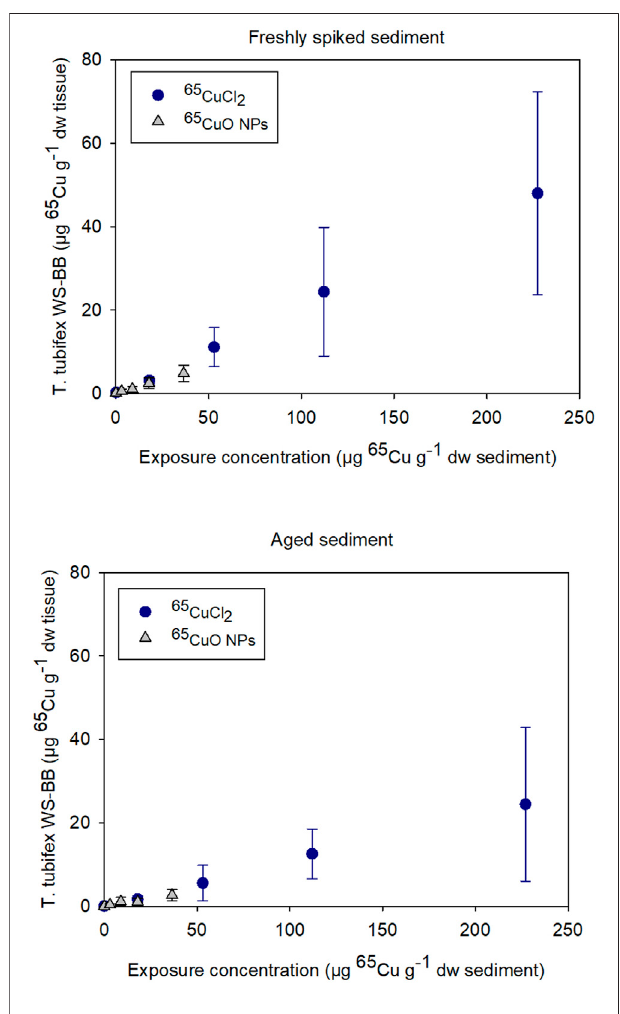
FIGURE 1 | Weight-speci fi c body burden (WS-BB) of newly accumulated 65 Cuin T.tubifex after 28-day exposure to fi